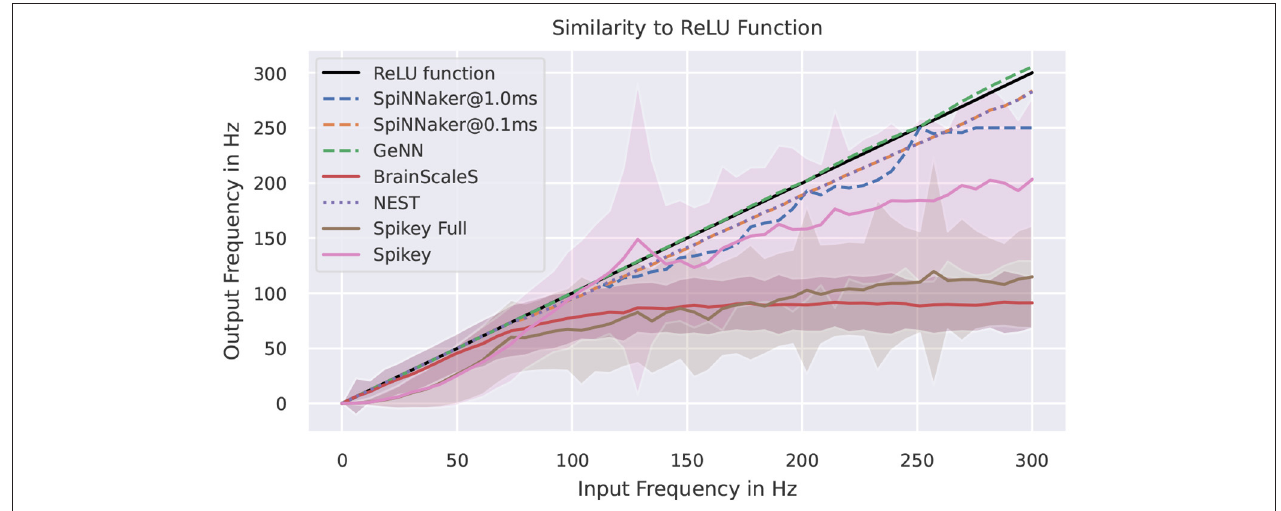
FIGURE 6 | Activation curves for various simulators. “Spikey Full” refers to the usage of both neuron blocks on the Spikey system. The target curve is depicted in black. SpiNNaker is tested with two different simulation timesteps.